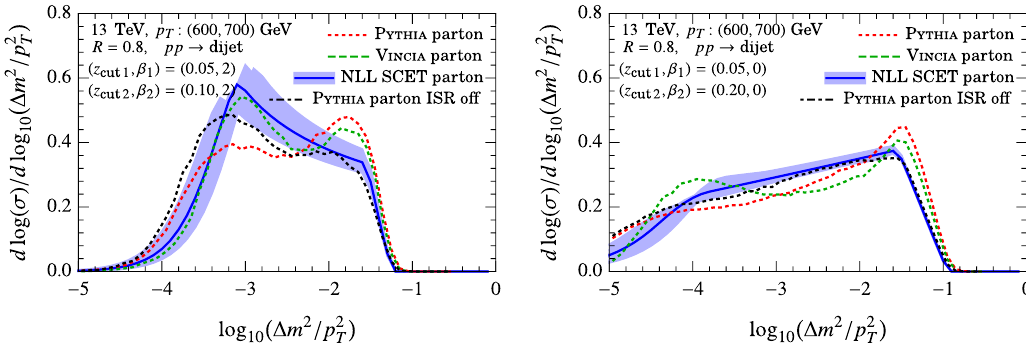
Figure 20 . More Collinear Drop distributions with ( z cut1 ; (cid:12) 1 ) = (0 : 05 ; 2) and ( z cut2 ; (cid:12) 2 ) = (0 : 1 ; 2) (left panel) and ( z cut1 ; (cid:12) 1 ) = (0 : 05 ; 0) and ( z cut2 ; (cid:12) 2 ) = (0 : 2 ; 0) (right panel) from Pythia and Vincia simulations as well as SCET calculations. Results from Pythia simulations with initial state radiation turned o(cid:11) are also